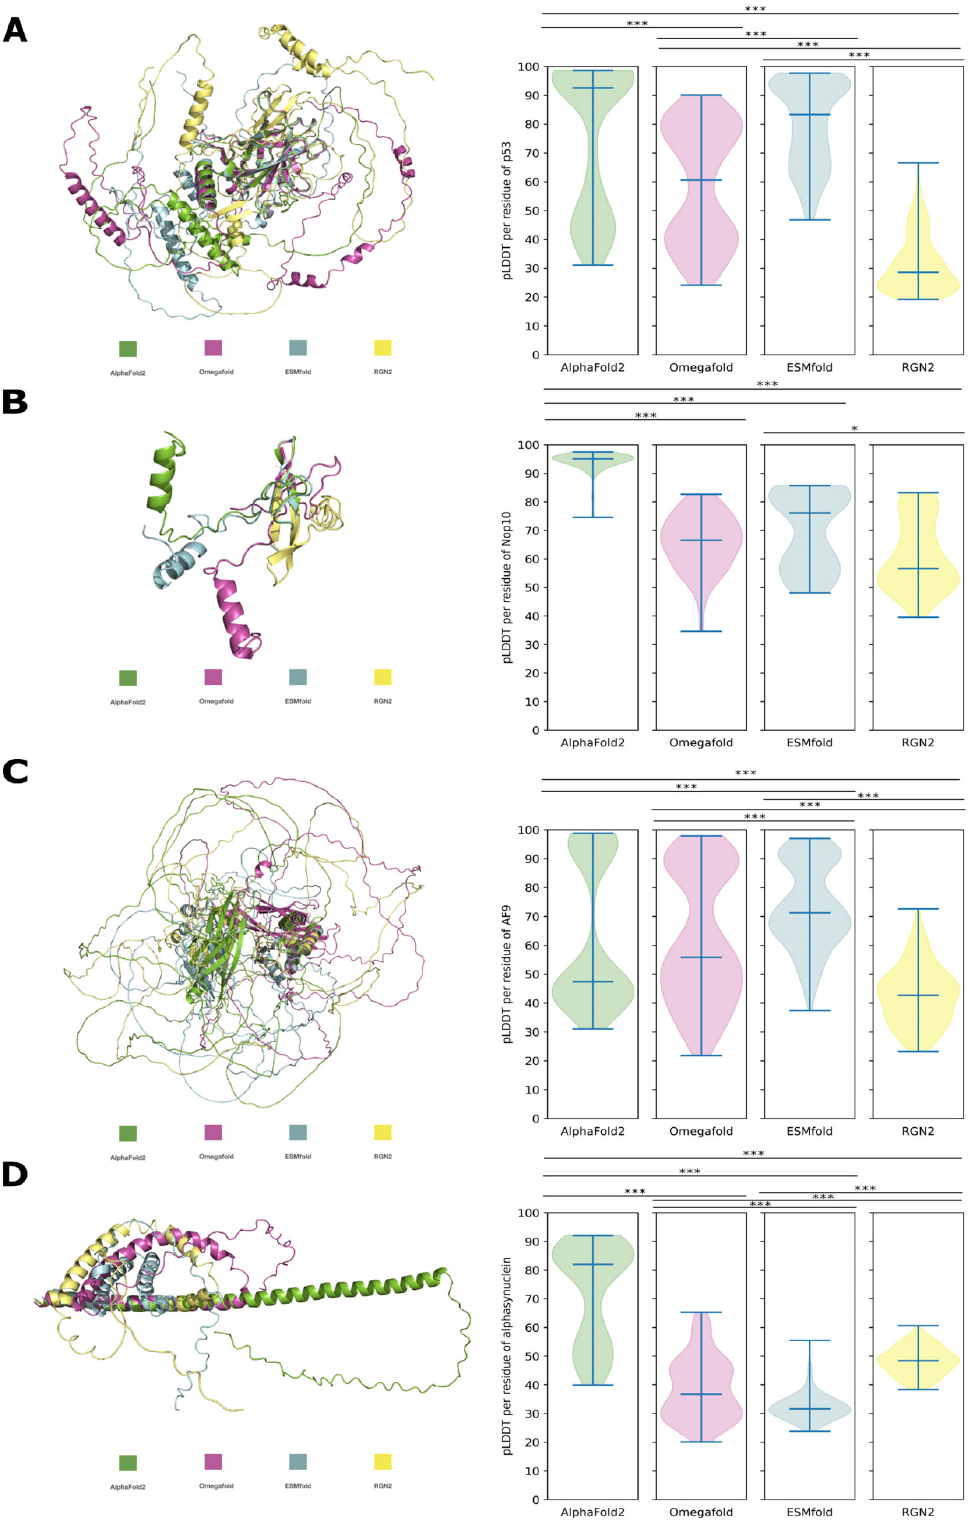
Figure 4. Comparison of pLDDT of different structure predictions for experimentally confirmed disordered proteins: Structural alignment of all models to a respective secondary element of the AF2 prediction and violin plots of pLDDT per residue of each model. A: p53, to β -sheets (C123-E203), C α -RMSD = 19.198Å. B: Nop10, to β -sheets (M4-T16), C α -RMSD = 0.269Å. C: AF9, to to α -helices (K500-S566), C α -RMSD = 1.558Å. D: alphasynuclein, to α -helix (M1-G40), C α -RMSD = 1.140Å. Significant difference in pLDDT is indicated by *, **, *** (p-value < 0.05 < 0.005 < 0.0005).